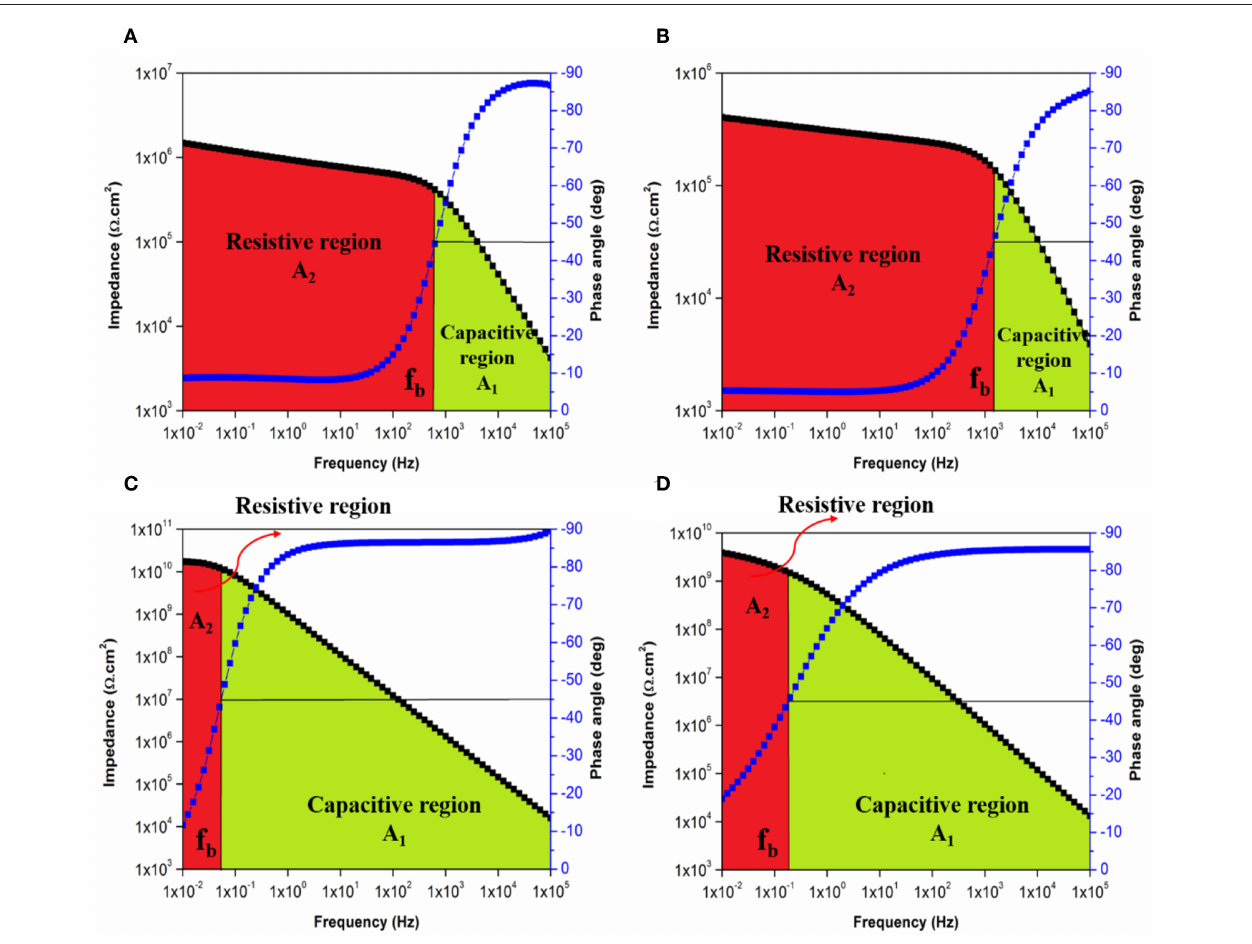
FIGURE 13 | Bode plot with breakpoint frequency determination of EP coating system after (A) 1 day and (B) 30 days and of EPT1 coating system after (C) 1 day and (D) 30 days of immersion with the corresponding capacitive (A 1 ) and resistive (A 2 ) regions.